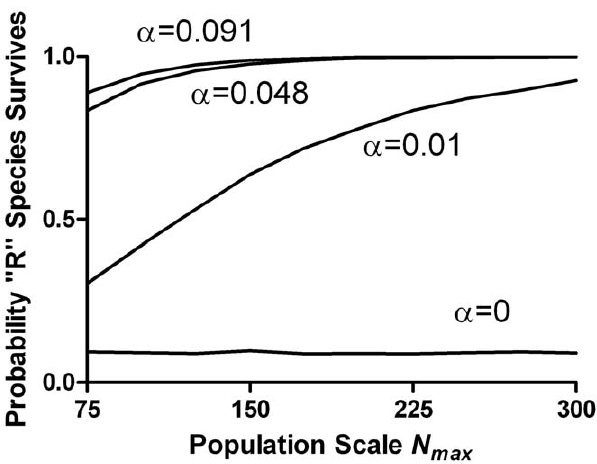
Figure 5. Effect of population size on selection for or against the risk-taking species. The fraction of trials in which the ‘‘R’’ species prevailed, at the maximum risk level ( r =10, p =0.1) as a function of the population size parameter n max for several values of the ‘‘cultural inheritance’’ rate a , or in the absence of cultural inheritance ( a =0). When a =0 there is no systematic effect of population size, because the ‘‘intrinsic risk aversion’’ due to the negative correlation of population- size fluctuations between generations scales in the same way as drift. When a . 0 the positive inter-generational fecundity correlation competes with intrinsic risk aversion, prevailing in larger populations and higher values of a .